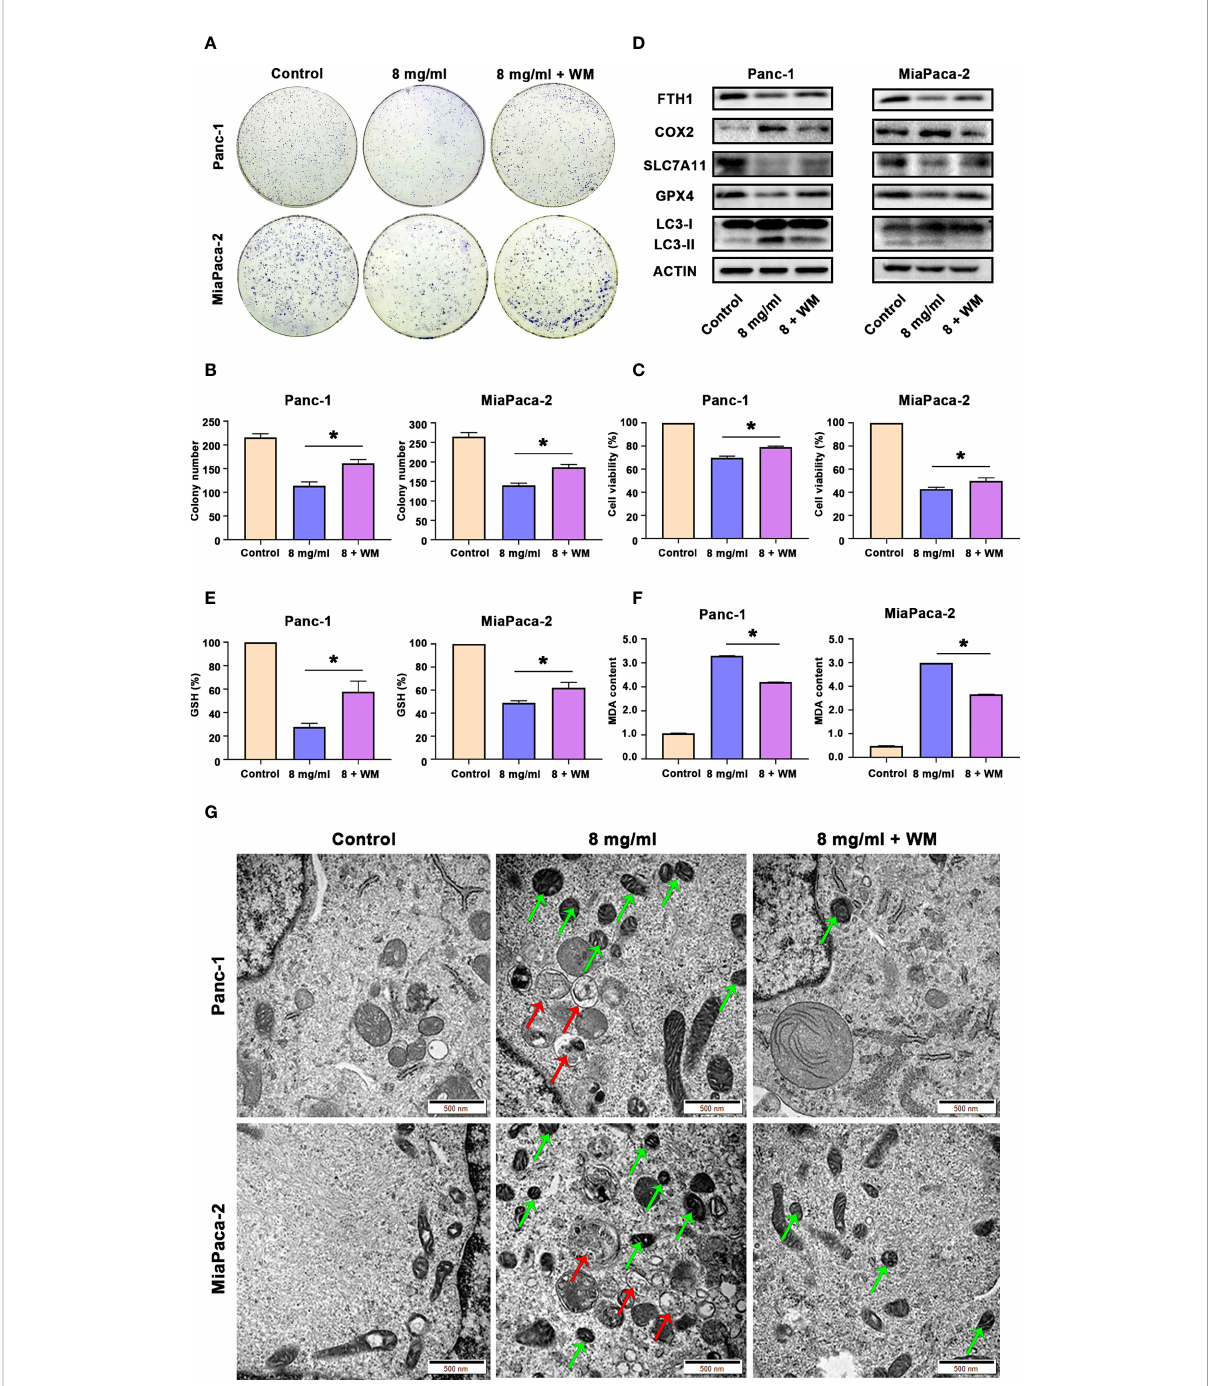
FIGURE 6 Huaier promoted ferroptosis by activating autophagy in pancreatic cancer cells. (A, B) Colony formation assay and its statistical analysis show cell proliferation of Panc-1 and MiaPaCa-2 cells after the control, Huaier and Huaier plus wortmannin (WM) treatments for 2 weeks. (C) CCK8 assay showing the viability of Panc-1 and MiaPaCa-2 cells after the control, Huaier and Huaier plus WM treatments for 96 h. (D) Western blotting showing the protein levels of FTH1, COX2, SLC7A11, GPX4 and LC3 in Panc-1 and MiaPaCa-2 cells treated with control, Huaier or Huaier plus WM. (E, F) The measurement of GSH and MDA concentrations in Panc-1 and MiaPaCa-2 cells after the control, Huaier and Huaier plus WM treatments. (G) TEM images showed ferroptosis-like mitochondria (green arrows) and autophagosomes (red arrows) in Panc-1 and MiaPaCa-2 cells after the control, Huaier and Huaier plus WM treatments. *P < 0.05, scale bar = 500